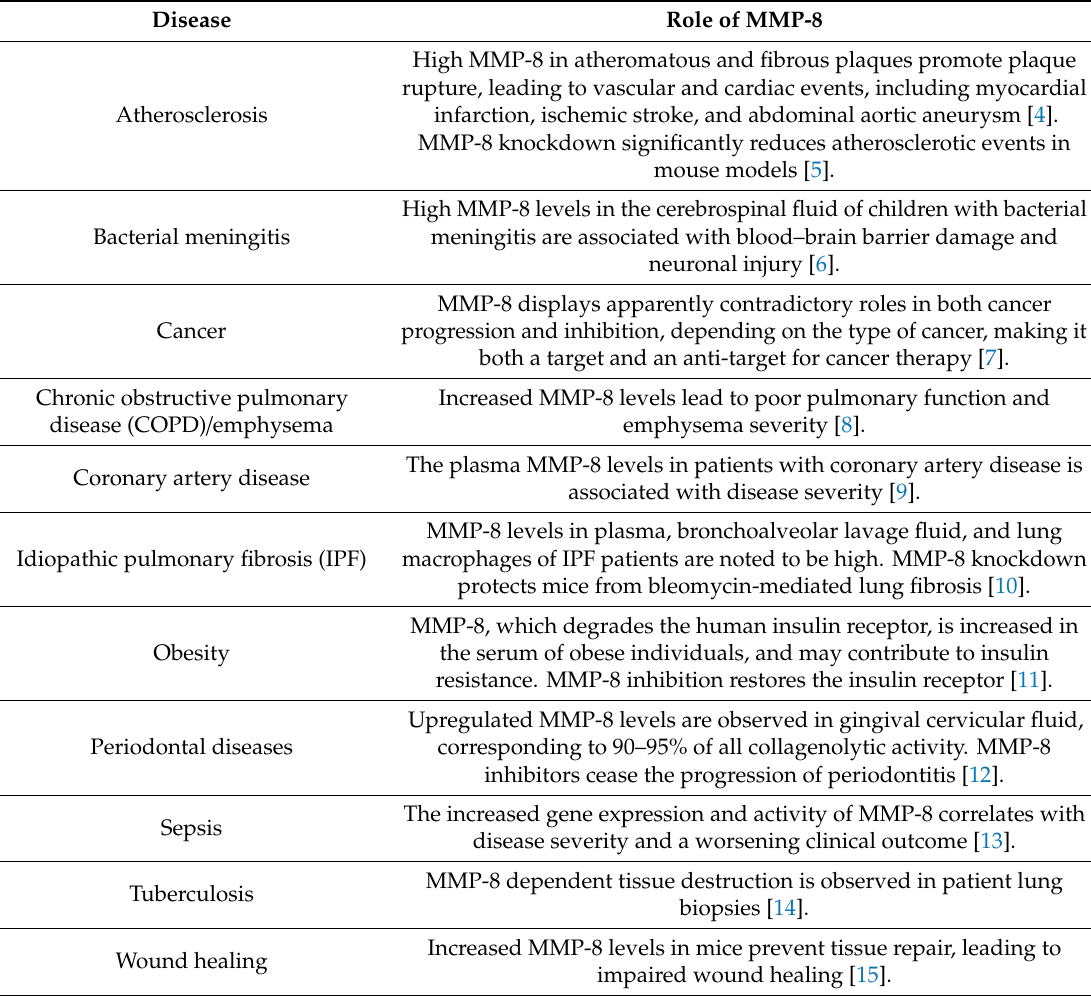
Table 1. Matrix metalloproteinase-8 (MMP-8) in various